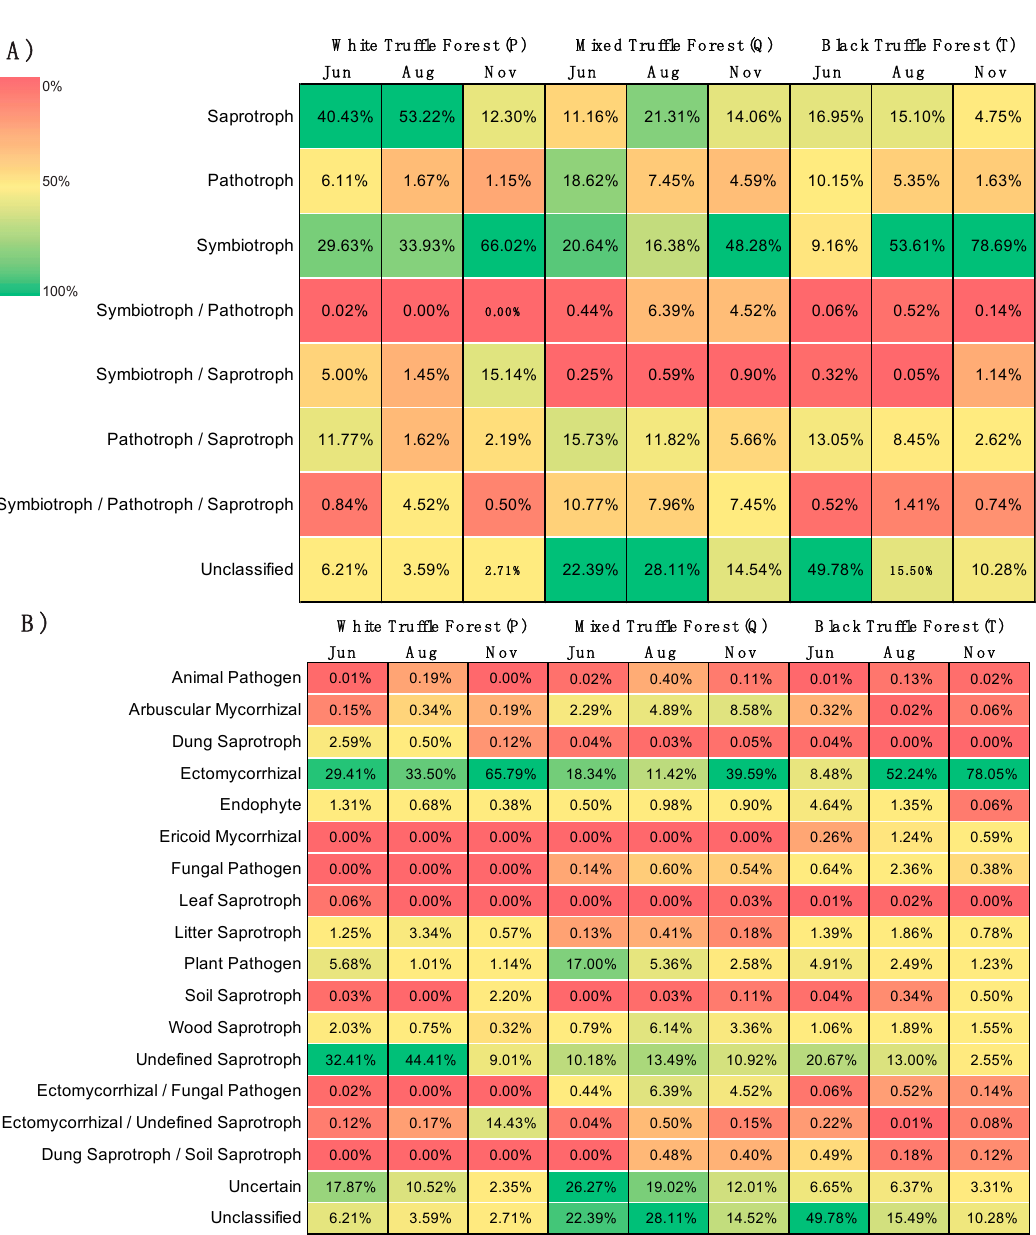
Figure 7. Relative abundance-based heat-maps showing seasonal variations in fungal trophic modes ( A ) and functional guilds ( B ) inferred by FUNGuild in white, mixed, and black truffle-producing forests in Serbian riparian forests. The values in each color block represents the relative abundance (%) of the respective trophic mode or functional guild.